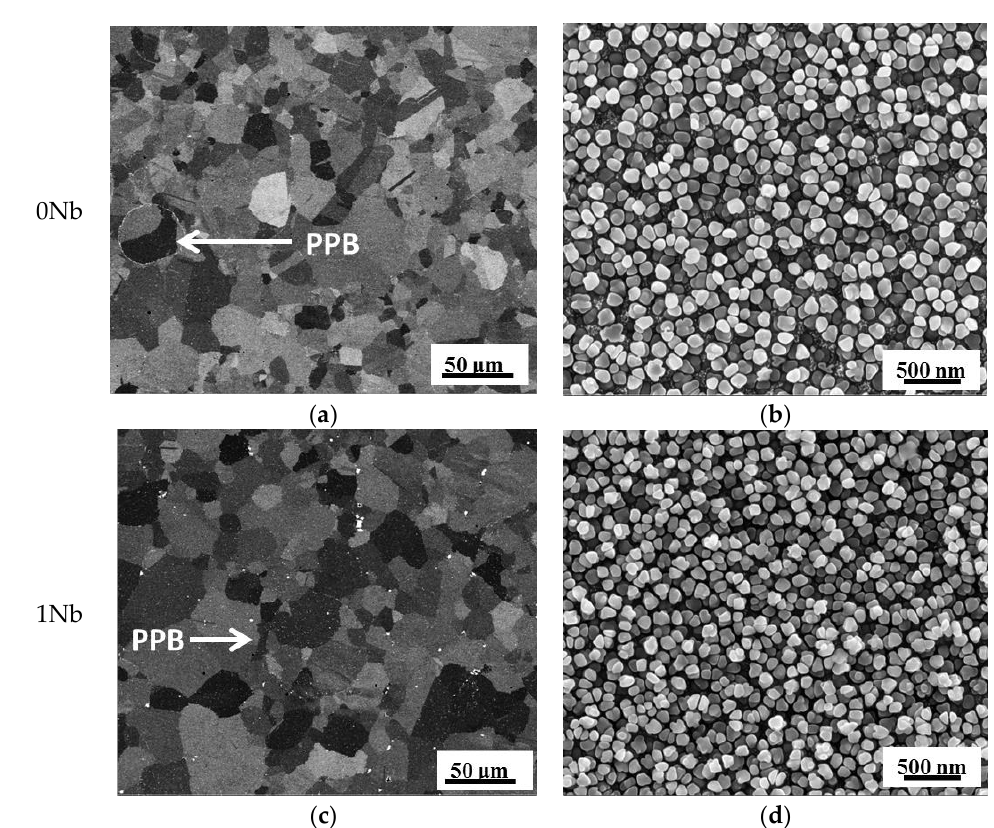
Figure 2. Microstructure of the 0Nb ( a,b ) and 1Nb ( c,d ) alloys after standard heat treatment (SHT) ( a,c ) backscatter electron (BSE) images; ( b,d ) second electron (SE) images.